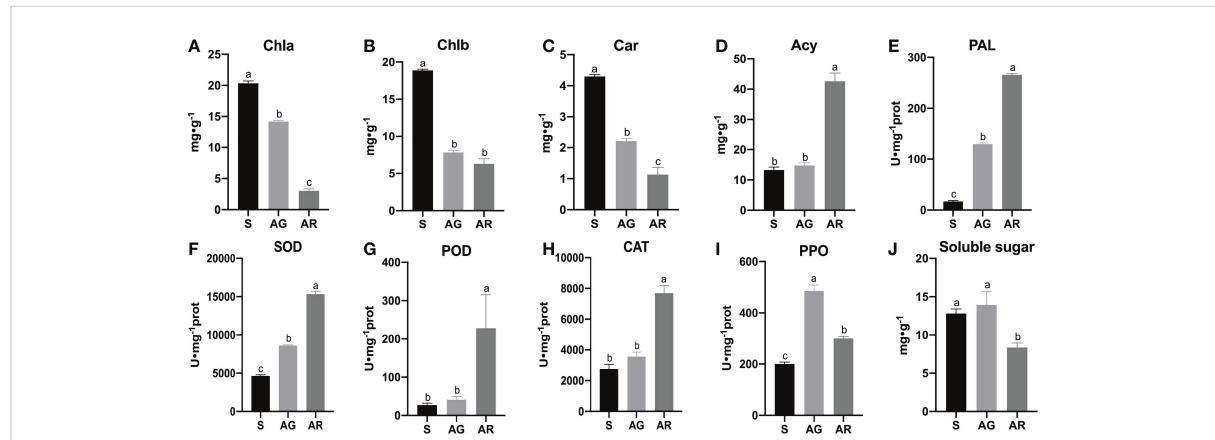
FIGURE 2 Biochemical indexes of A. p. subsp. mono leaves. (A – J) show the contents of chlorophyll a, chlorophyll b, carotenoid, anthocyanin, PAL, SOD, POD, CAT, PPO, and soluble sugar in the leaves of A. p. subsp. mono at three stages of S, AG, and AR, respectively. S, AG, and AR denote bud mutation branch leaves in summer, wild branch leaves in autumn, and bud mutation branch leaves in autumn,